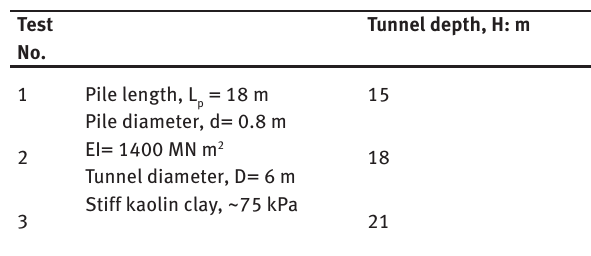
Table 6: Details of centrifuge tests (prototype scale), Logagnathan et al.